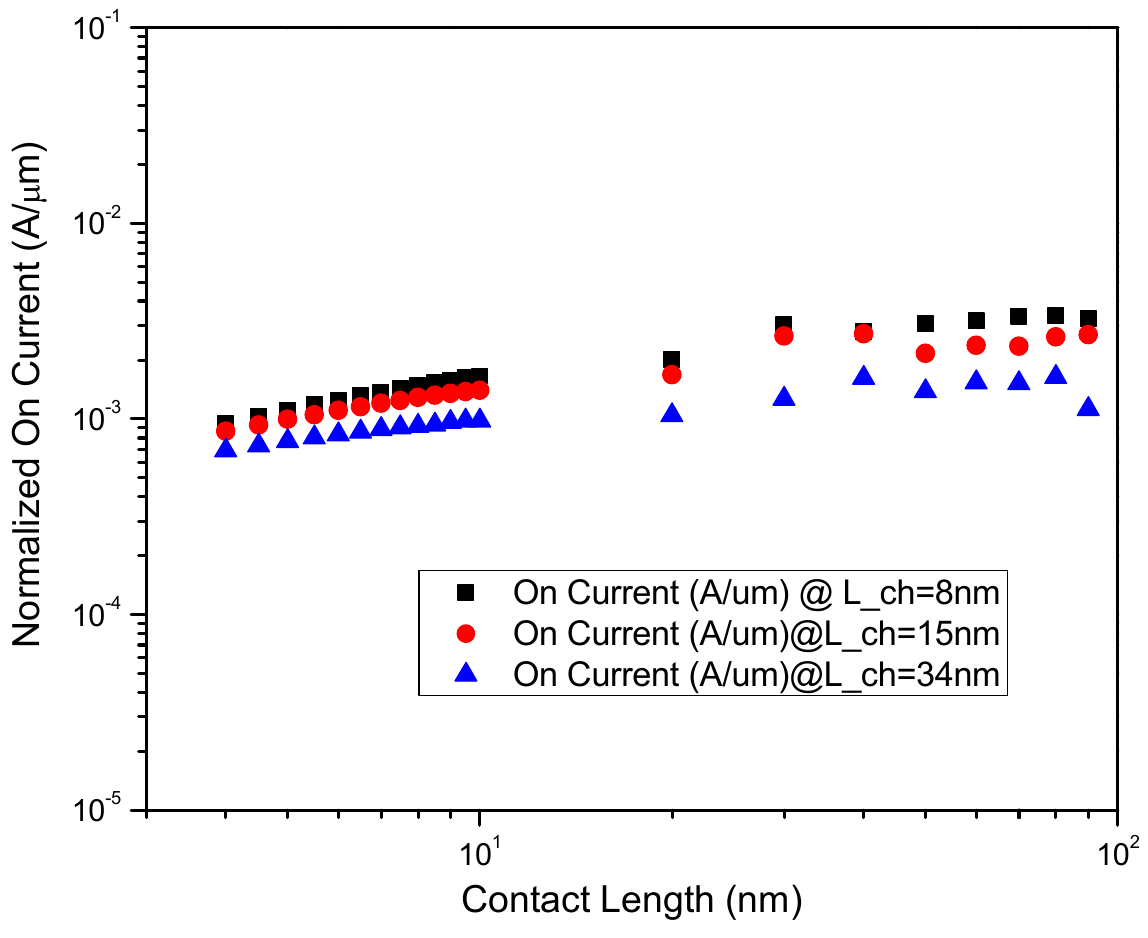
Figure 10. Normalized On-Current (in A/ µ m) vs. Contact length (in nm) for Lch = 10 nm. No dependence of Ion on Lcon suggest that carrier injection is only prevalent at the edge of the metal directly into the MoS2 channel.